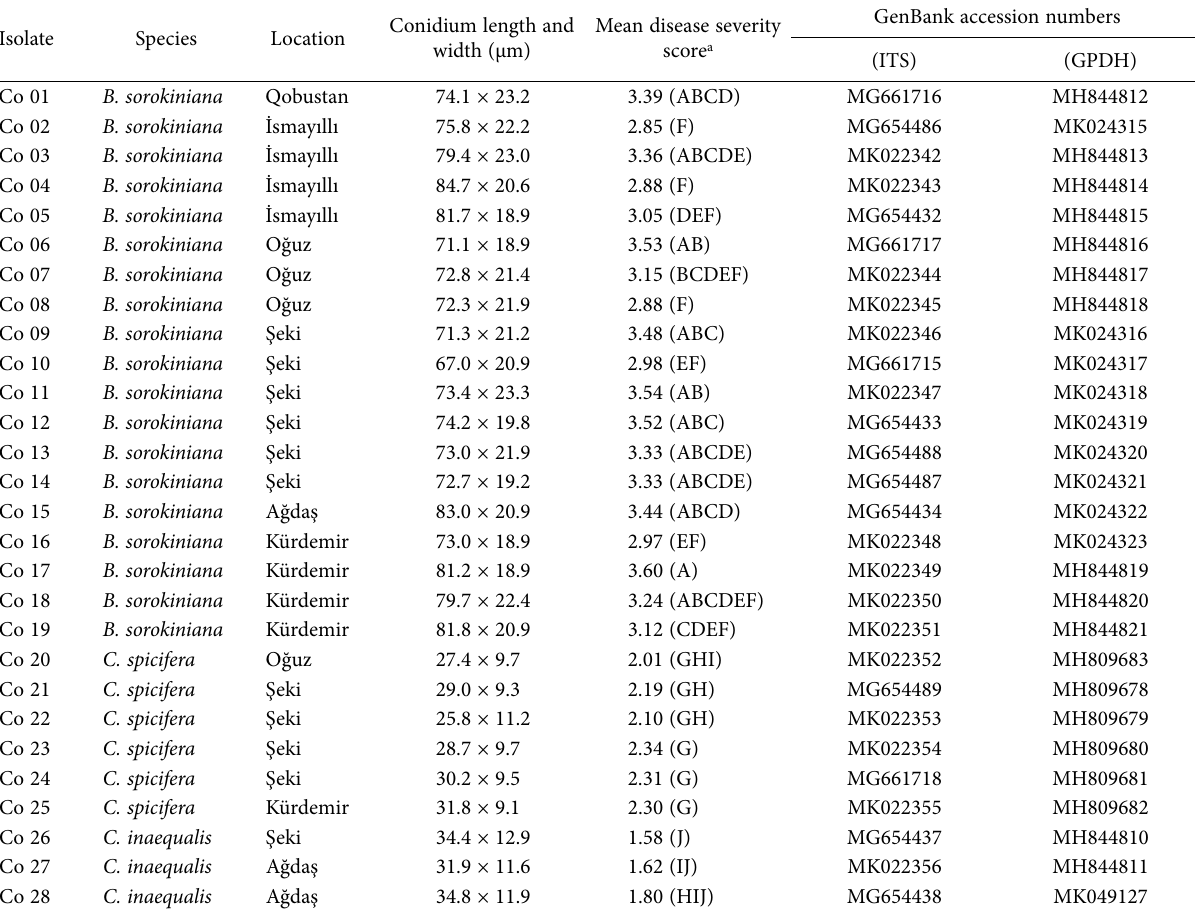
Table 1. Isolates, their identities, locations, mean conidium dimensions, mean disease severity scores, and GenBank accession numbers related to sequences of their ITS and GPDH